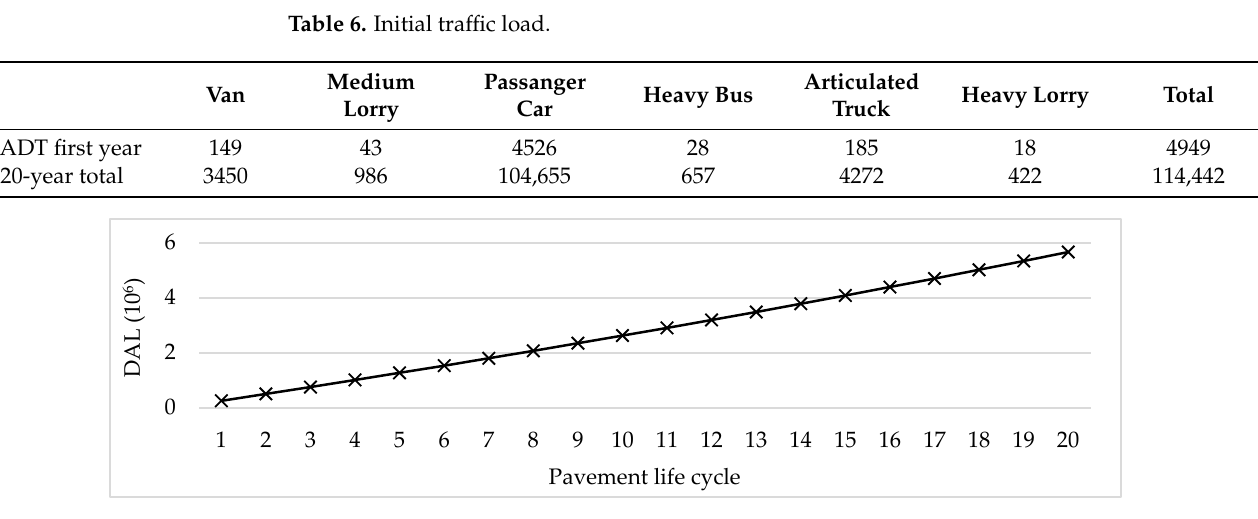
Figure 5. Number of design axle loads during the pavement’s life cycle.